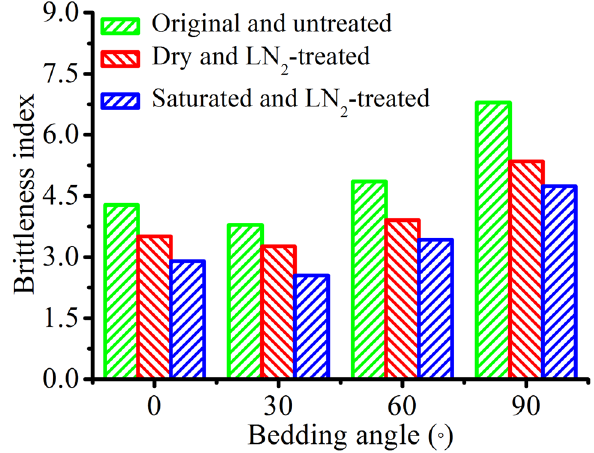
Fig. 11 Schematic diagram for calculating the brittleness index